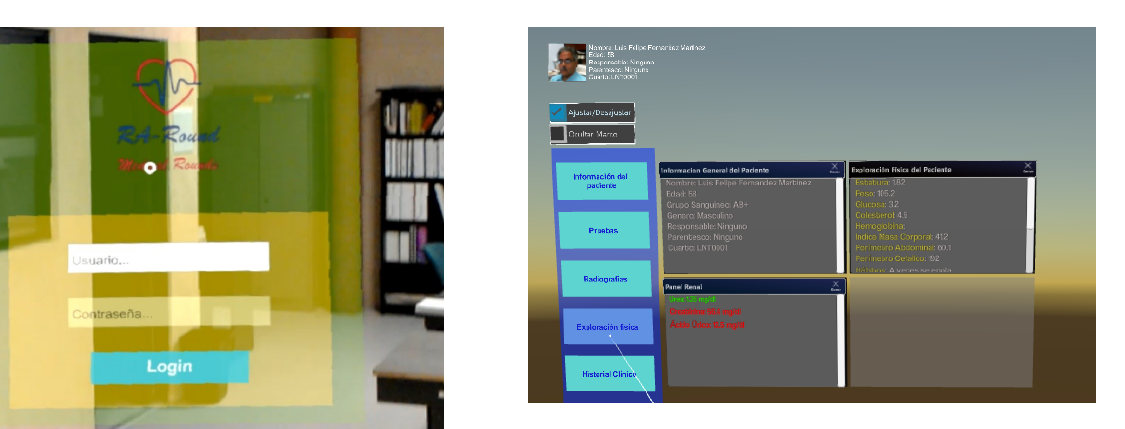
Figure 7. Around Frame with patient information.